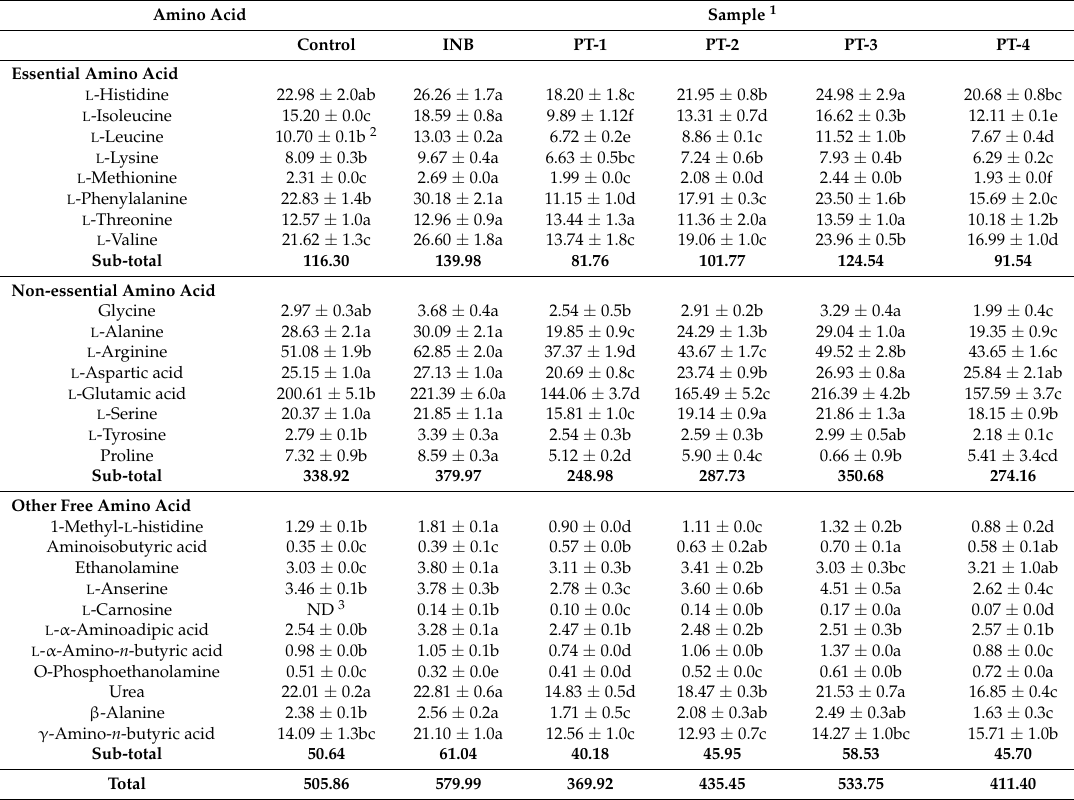
Table 3. Free amino acid composition (mg/g of dry weight) of soybean sprouts cultivated with Indolbi (INB) or persimmon fruit powder